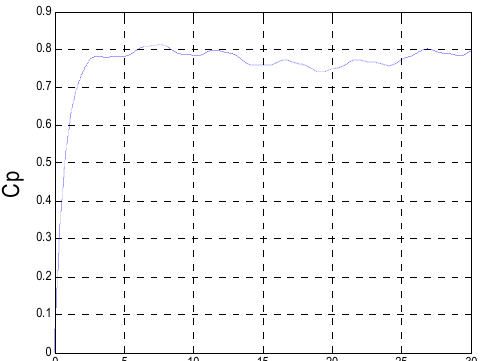
Figure 4. Power coe ffi cient.